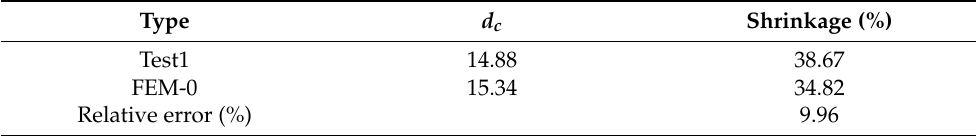
Table 7. Comparison of shrinkage (%) of the variable cross-section in FEM-0 and Test 1.